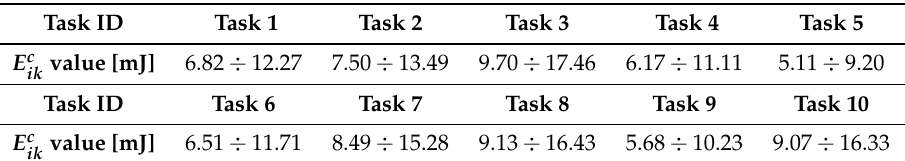
Table 1. Energy consumption values per task’s single execution.